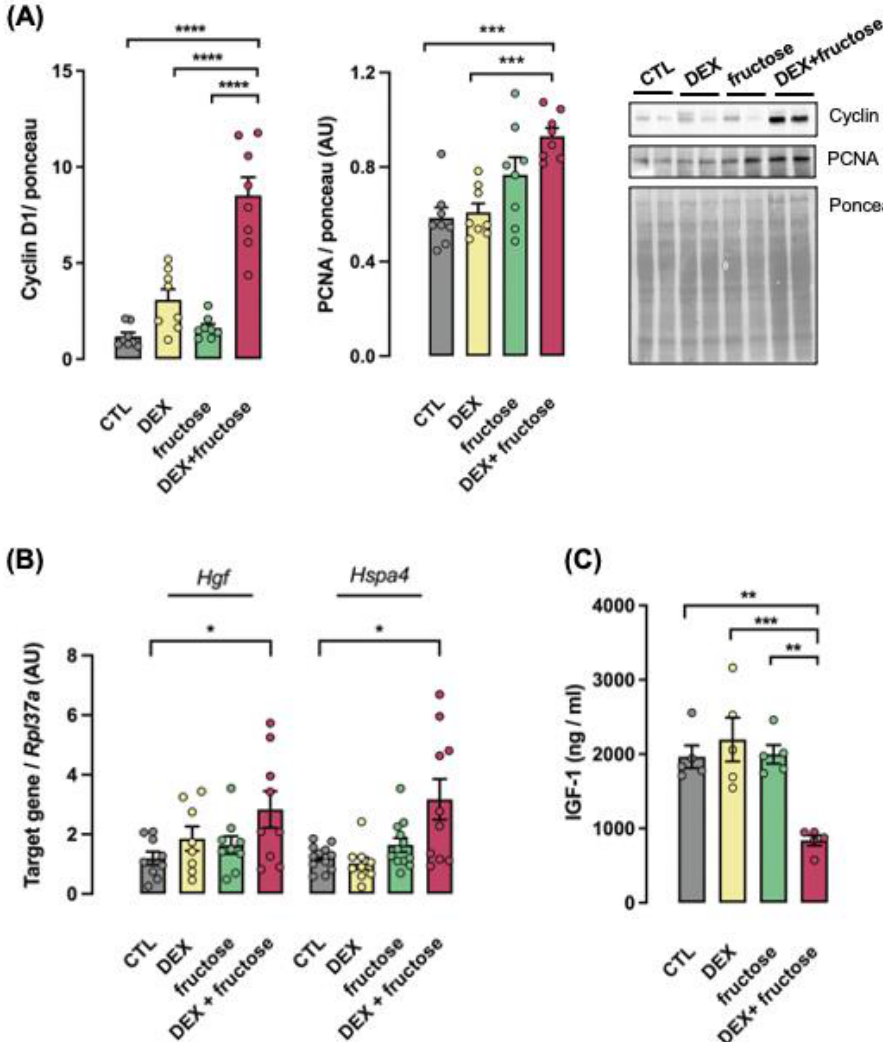
Figure 7. Markers of HCC increased in rats born to DEX-treated mothers and that chronically consumed fructose in adult life. Liver and blood samples were collected from adult rats supplemented (fructose and DEX+fructose groups) or not (CTL and DEX groups) with fructose for 8 weeks. Liver samples were used for immunoblotting detection of Cyclin D1 and PCNA ( A ), and qPCR detection of Hgf and Hspa4/Hsp70 expressions ( B ). Band intensities of immunoblotting experiments were normalized by the signal from Ponceau staining. Blood samples were used to measure circulating IGF-1 ( C ). Data are presented as the mean ± SEM; * p < 0.05, ** p < 0.01, *** p < 0.001 and **** p < 0.001 vs. the group indicated by the bracket. In ( A ), n = 8; in ( B ), n = 8 to 12; in ( C ), n = 5. In addition to the markers mentioned above, the number of cells positive for Ki-67 were higher in the fructose–DEX but not in the fructose group when compared to CTL (126% higher; p < 0.01) (Figure